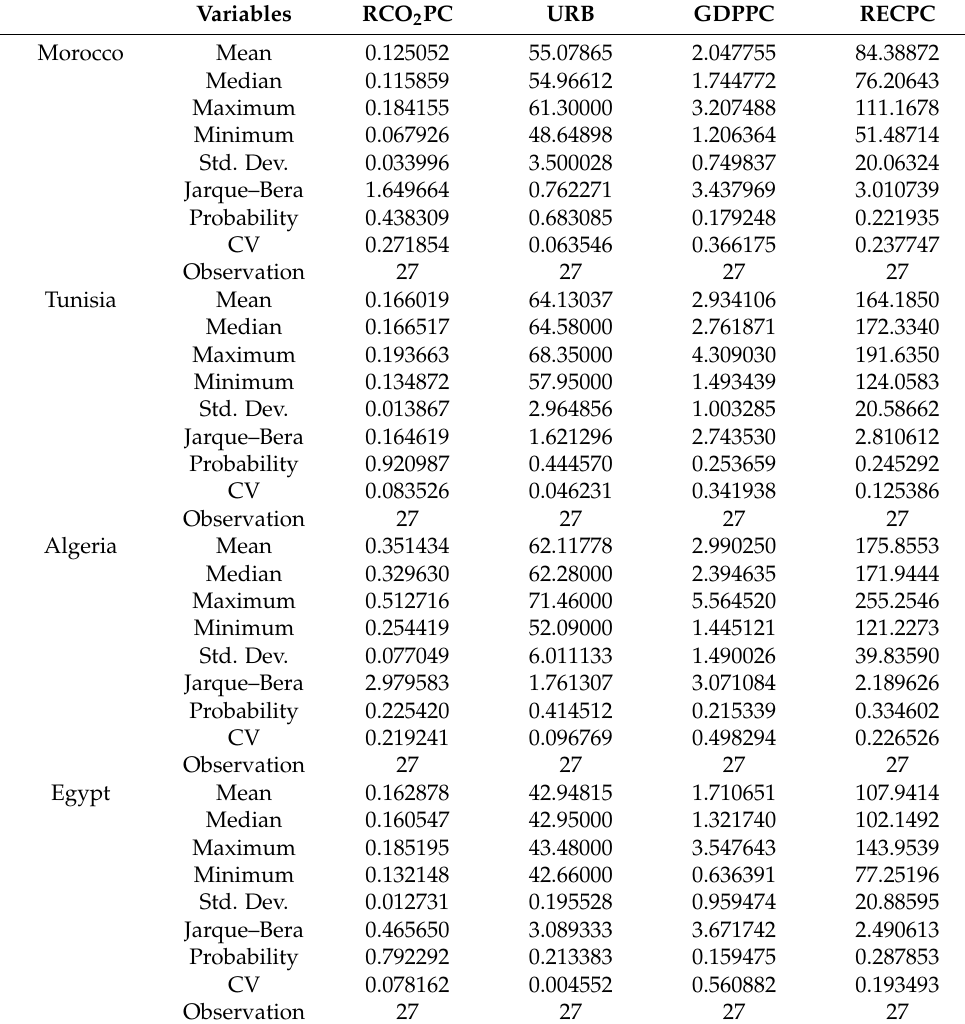
Table 2. Descriptive statistics of the